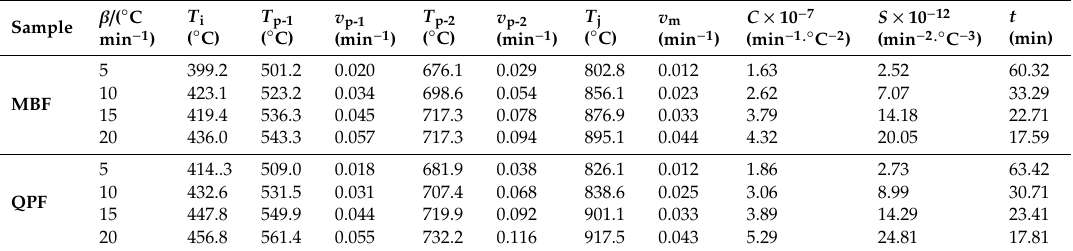
Table 5. Combustion characteristic parameters of MBF and QPF at di ff erent heating rates. Sample